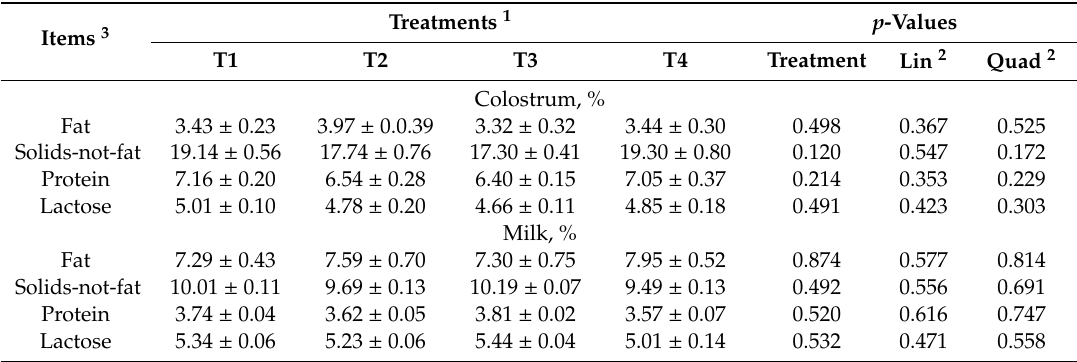
Table 5. E ff ects of the ratio of insoluble to soluble fiber in gestation diets on the composition of colostrum and